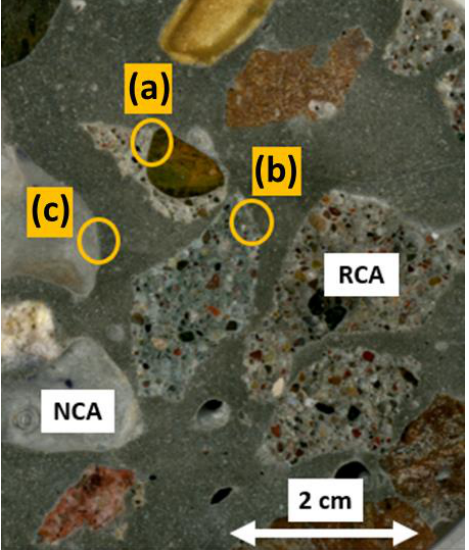
Figure 2. RCA 50 SF embedded in epoxy resin with a polished surface. ( a – c ) “areas of interest" for study in